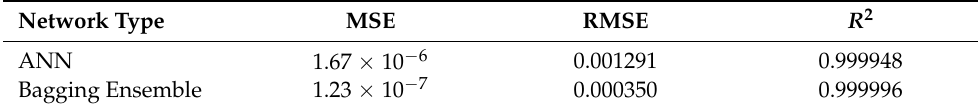
Table 4. Performance metrics: zero collateral.